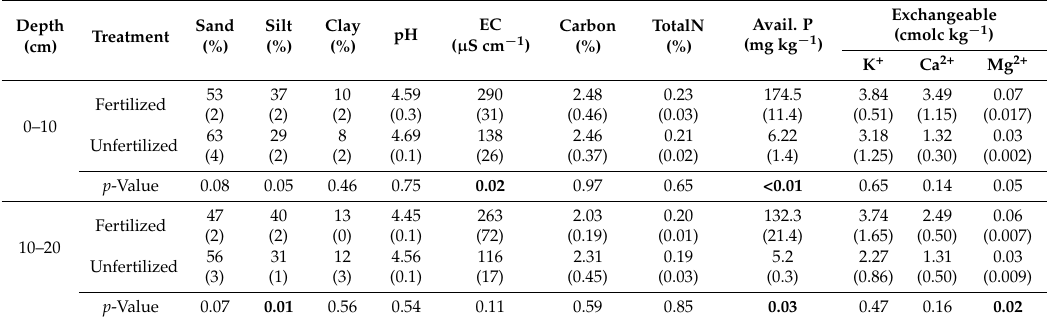
Table 2. Soil physiochemical properties between fertilized and unfertilized plots in a Moso bamboo stand ( n =